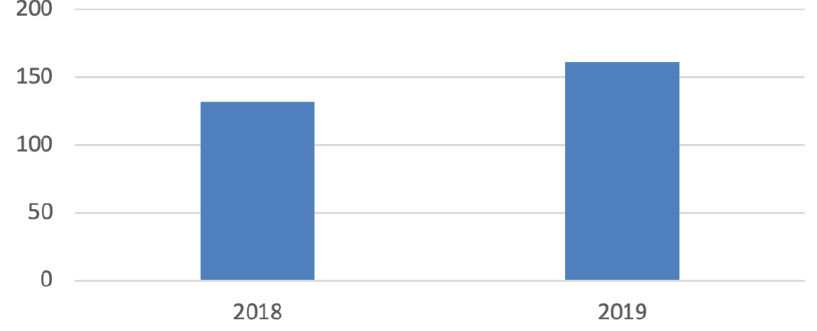
Figure 2 : Publications by year; Source: Research data